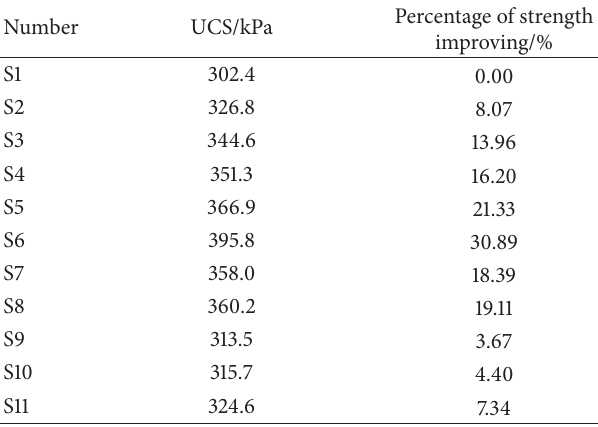
Figure 3: Effect of basalt fiber (BF) content on unconfined compres- sive strength (UCS) of soil samples.